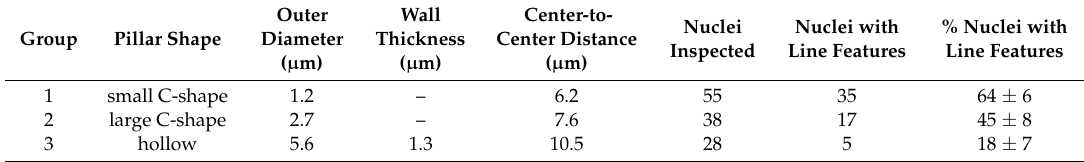
Table 1. Physical dimensions of micron and sub-micron scale silicon pillars. Statistical distributions of PC3 cells that show fine line features after incubation on silicon substrates with various pillar geometries for approximately 72 h. Data spreads correspond to one standard